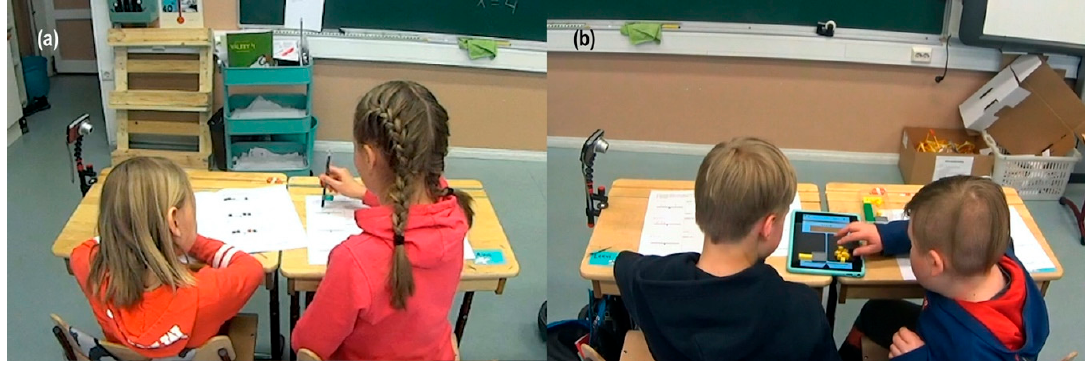
Figure 7. Pair work during the classroom interventions. ( a ) Paper-and-pencil condition; ( b ) X-is